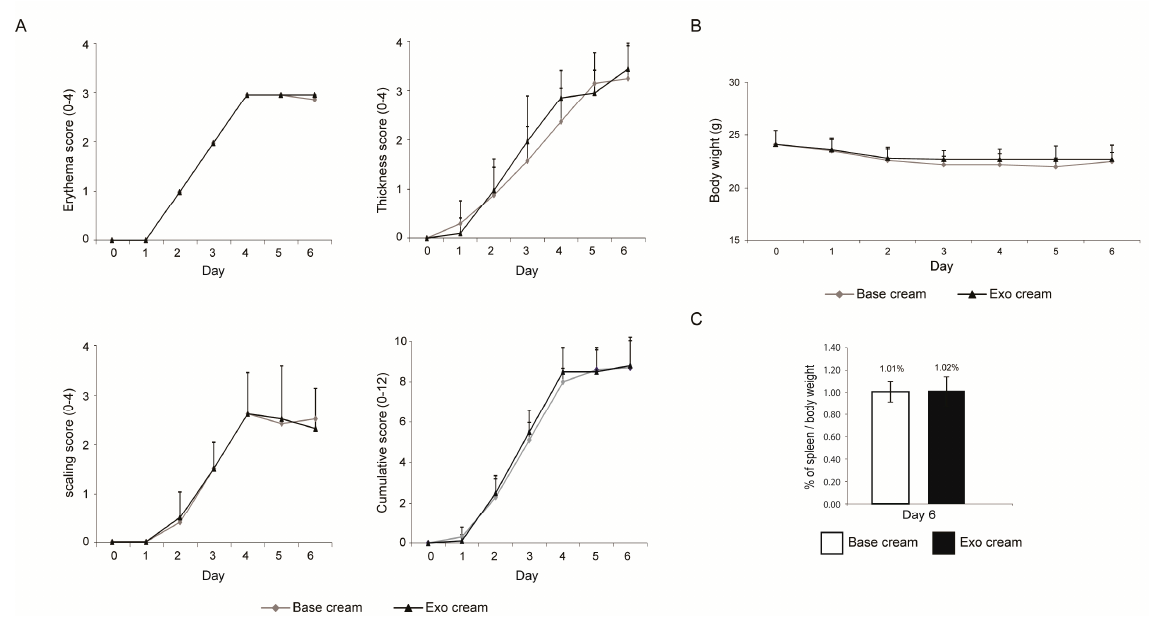
Figure 2. Skin phenotype score, body weight and ratio of spleen to body weight. ( A ) Erythema, scaling, and thickness of the back skin were scored independently daily from Day 0 to Day 6 (Expt. 1) on a scale from 0 to 4, and the cumulative score for erythema, scaling, and thickness over time was determined daily on a scale from 0–12. ( B ) The body weight (Day 0–6) and ( C ) ratio of spleen to body weight (Day 6) were also determined. Scoring (erythema, scaling, thickness, and cumulative score), body weights and ratio of spleen to body weight were analyzed using Student’s t-test. p values < 0.05 were considered as statistically significant. Int. J. Mol. Sci. 2020 , 21 , x FOR PEER REVIEW